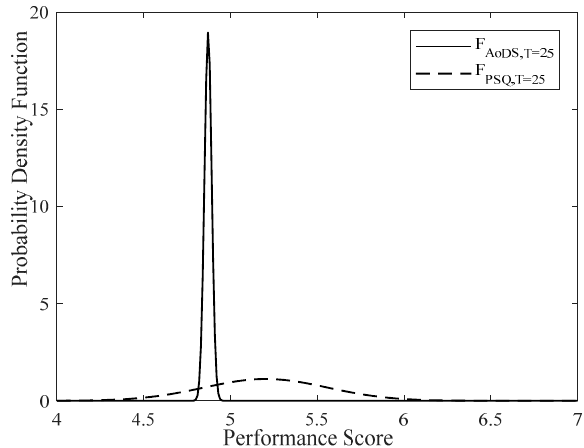
Figure 8. Reliability analysis for PPP schools in Australia case example at t = 25.